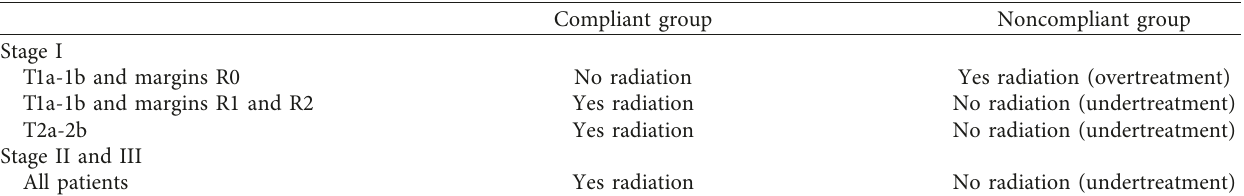
Table 1: Definition of compliance based on NCCN guidelines for radiation therapy in the treatment of extra-abdominal